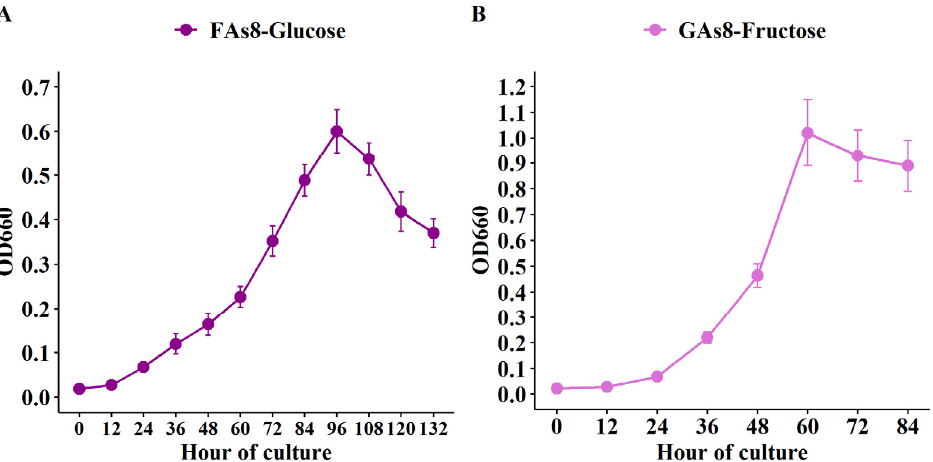
Figure 3. Growth pattern of the involved strains on different hexose sugars. ( A ) Growth pattern of FAs8 on fresh glucose medium. ( B ) Growth pattern of GAs8 on fresh fructose medium.